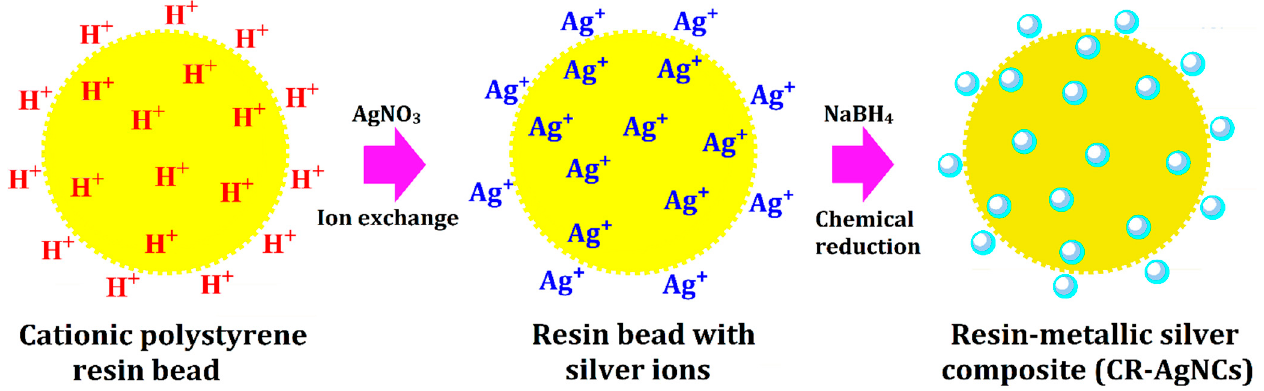
Figure 11. Schematic representation of formation of cationic polystyrene resin bound silver nanocomposite (CR-AgNCs).